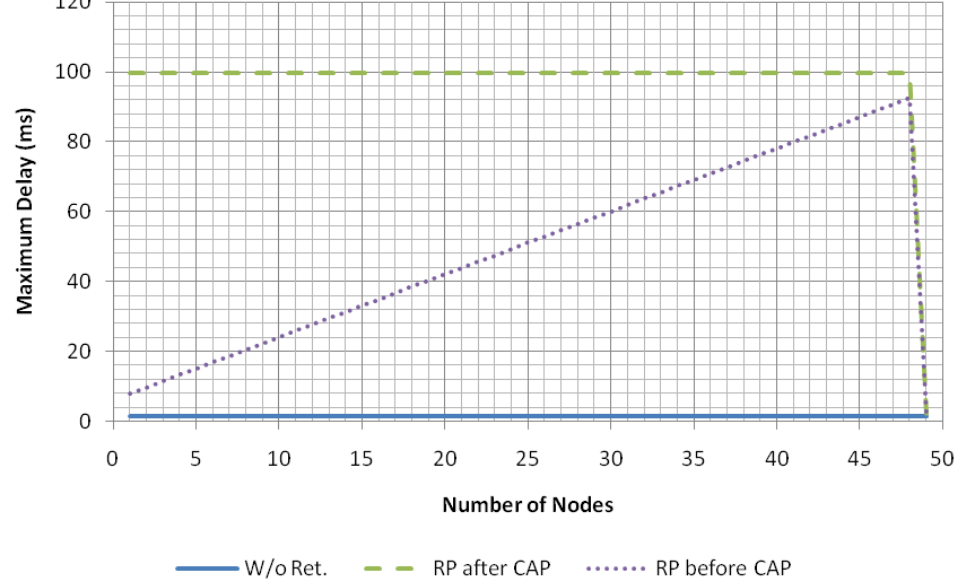
= 10 −2 (data) and 10 −4 (beacon). bad